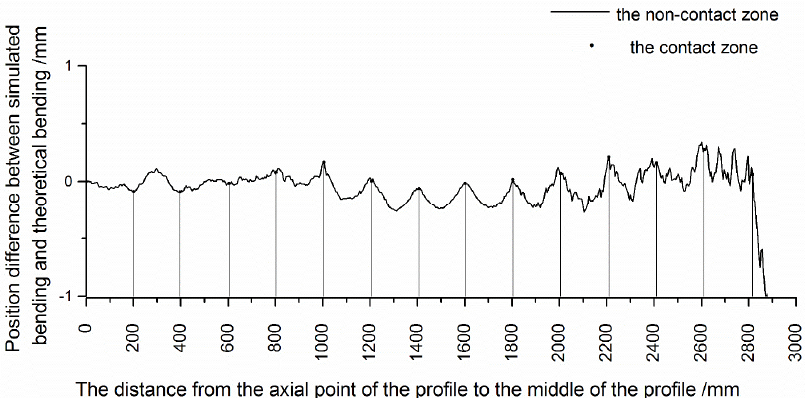
Figure 13. The displacement difference between simulated bending and theoretical bending of profile.